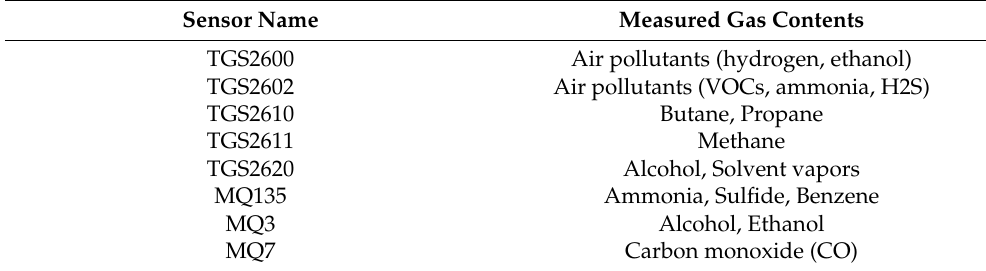
Table 1. Sensors of the developed e ‐ nose system.